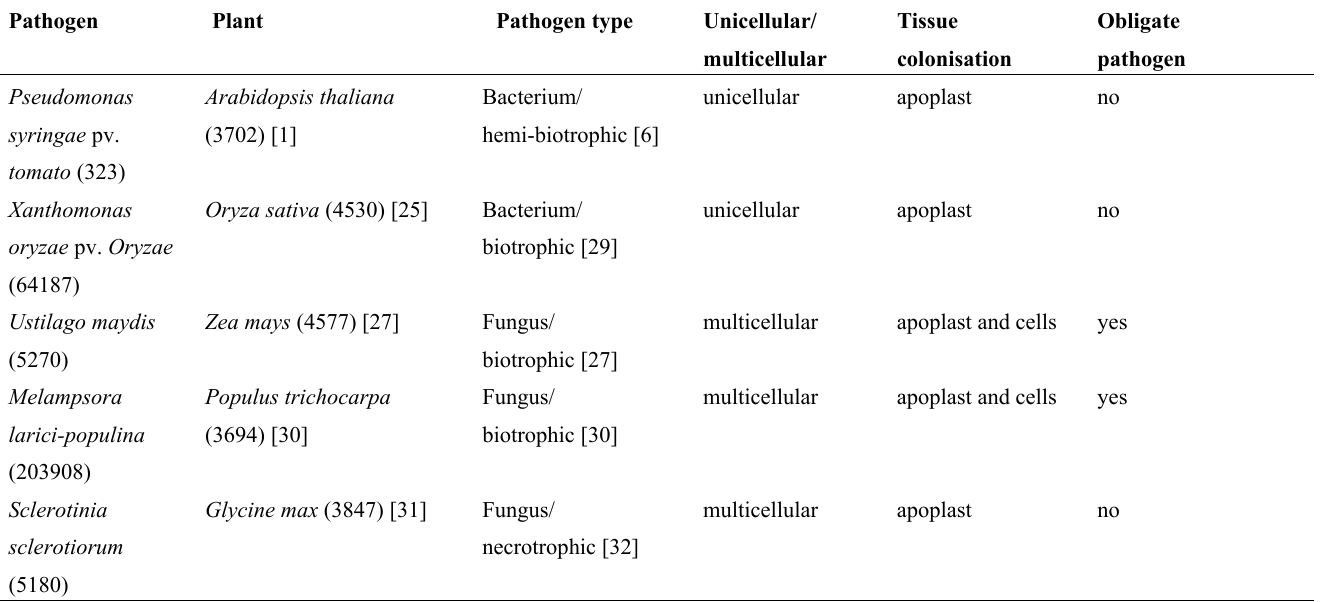
Table 1. Overview of the selected plant-pathogen pairs investigated in this study and associated key biological aspects. NCBI taxonomy numbers are given in the parentheses next to the species’ NCBI Taxonomy